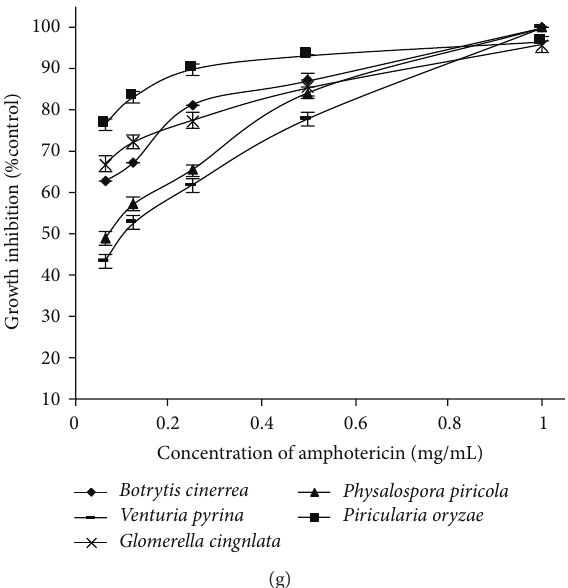
Figure 3: Inhibitory activity of extracts and fractions from Z. bungeanum leaves against 5 plant pathogenic fungi. Amphotericin was used as the positive